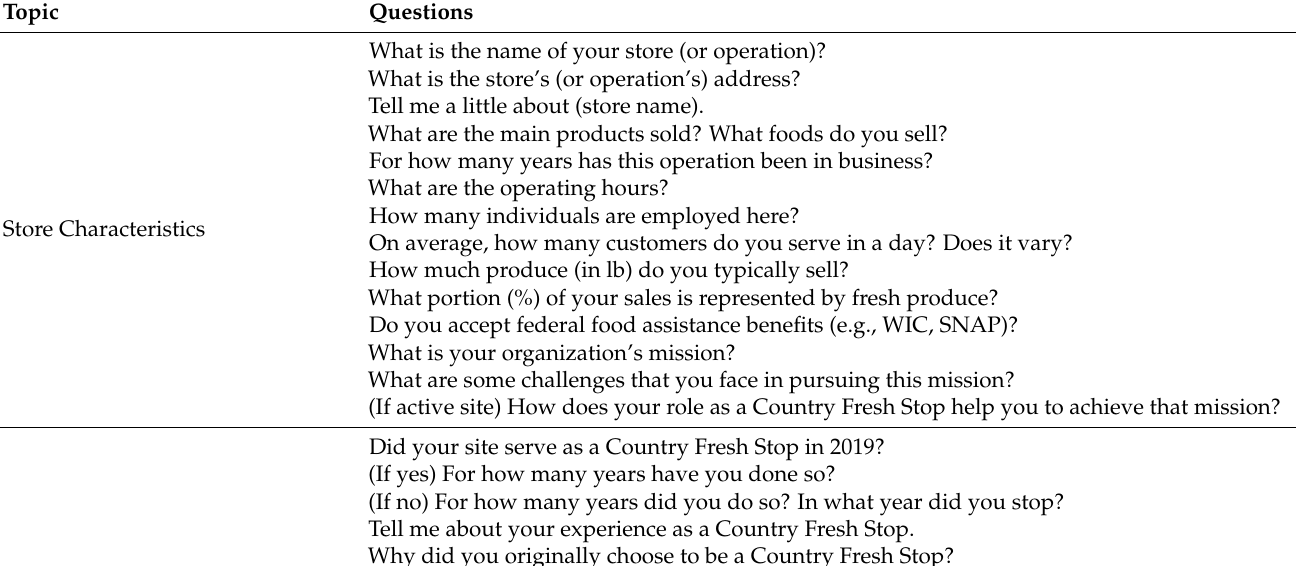
Table A1. Country Fresh Stop Site Interview